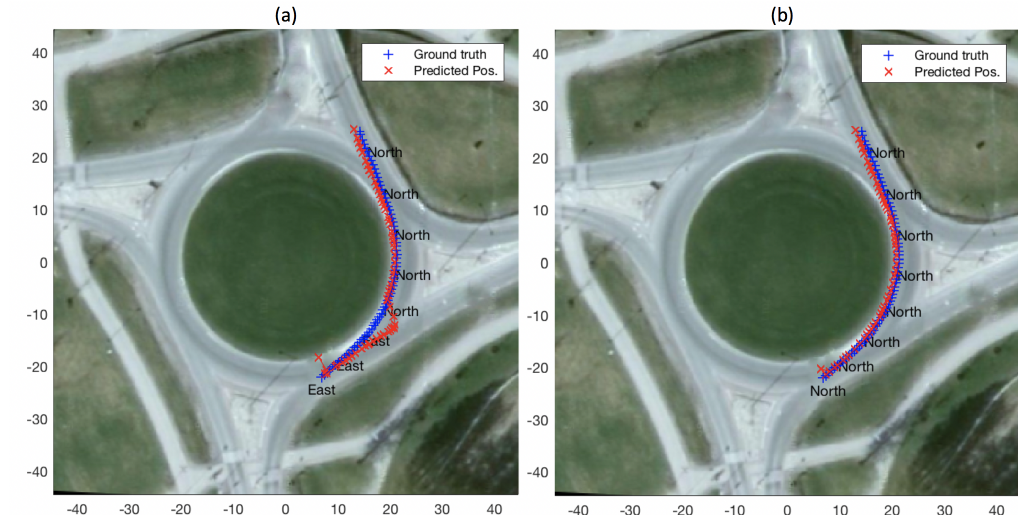
Figure 8. Exit-direction classification and state prediction using a set of reference trajectories as roundabout model: ( a ) employing 16 reference trajectories in the model; and ( b ) employing 100 reference in the model.